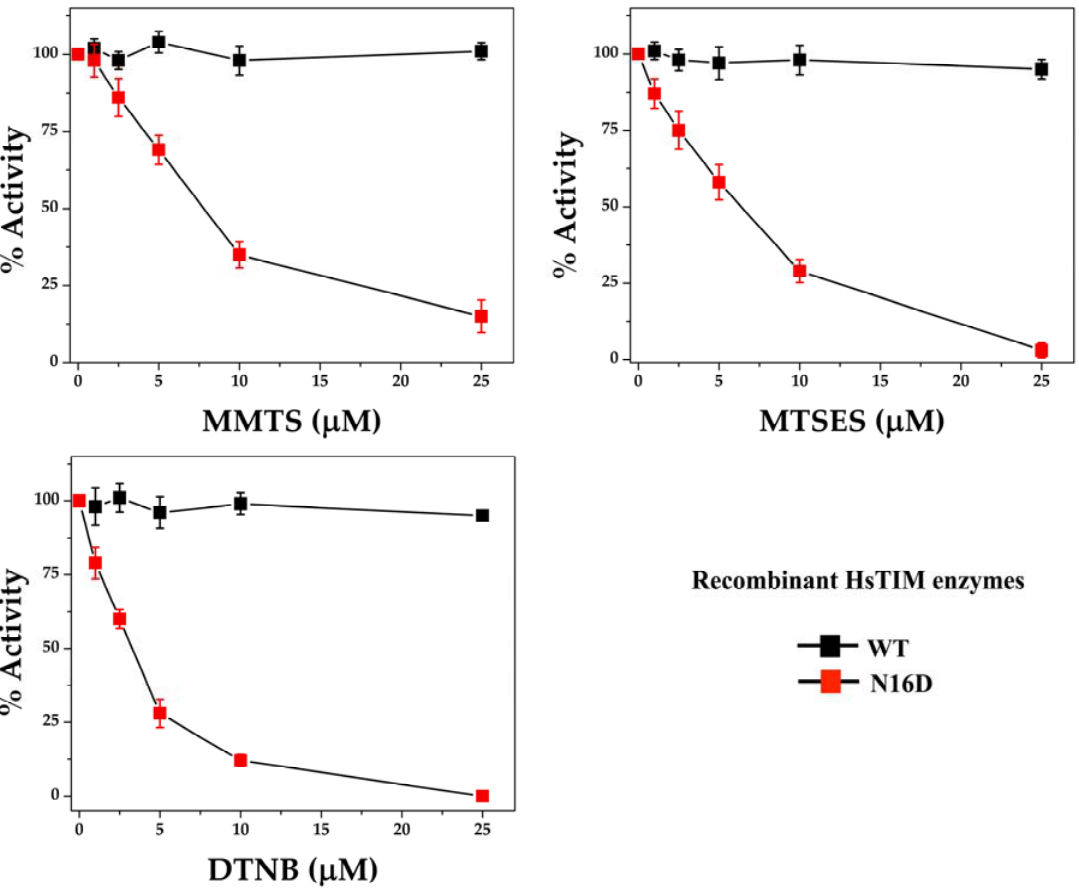
Figure 4. Inactivation assays of recombinant WT and N16D HsTIM enzymes. WT and N16D HsTIM were incubated at 0.5 mg / mL with 0, 1, 2.5, 5, 10 and 25 µ M methyl-methanethiosulfonate (MMTS), sodium 2-[(methylsulfonyl)sulfanyl] ethanesulfonate (MTSES) or DTNB. After the incubation time, aliquots were withdrawn at each experimental condition and assayed for their enzymatic activity. Enzyme activity was assayed using 5 and 50 ng mL of WT and N16D HsTIM, respectively. Table 1. Cys quantification in the WT and N16D HsTIM